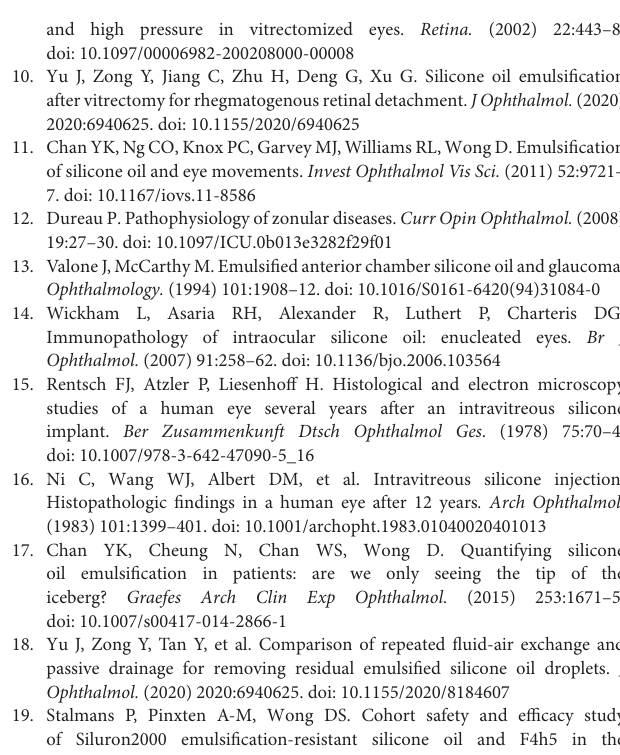
Supplementary Figure 1 | Ultrasound biomicroscopic images from a single